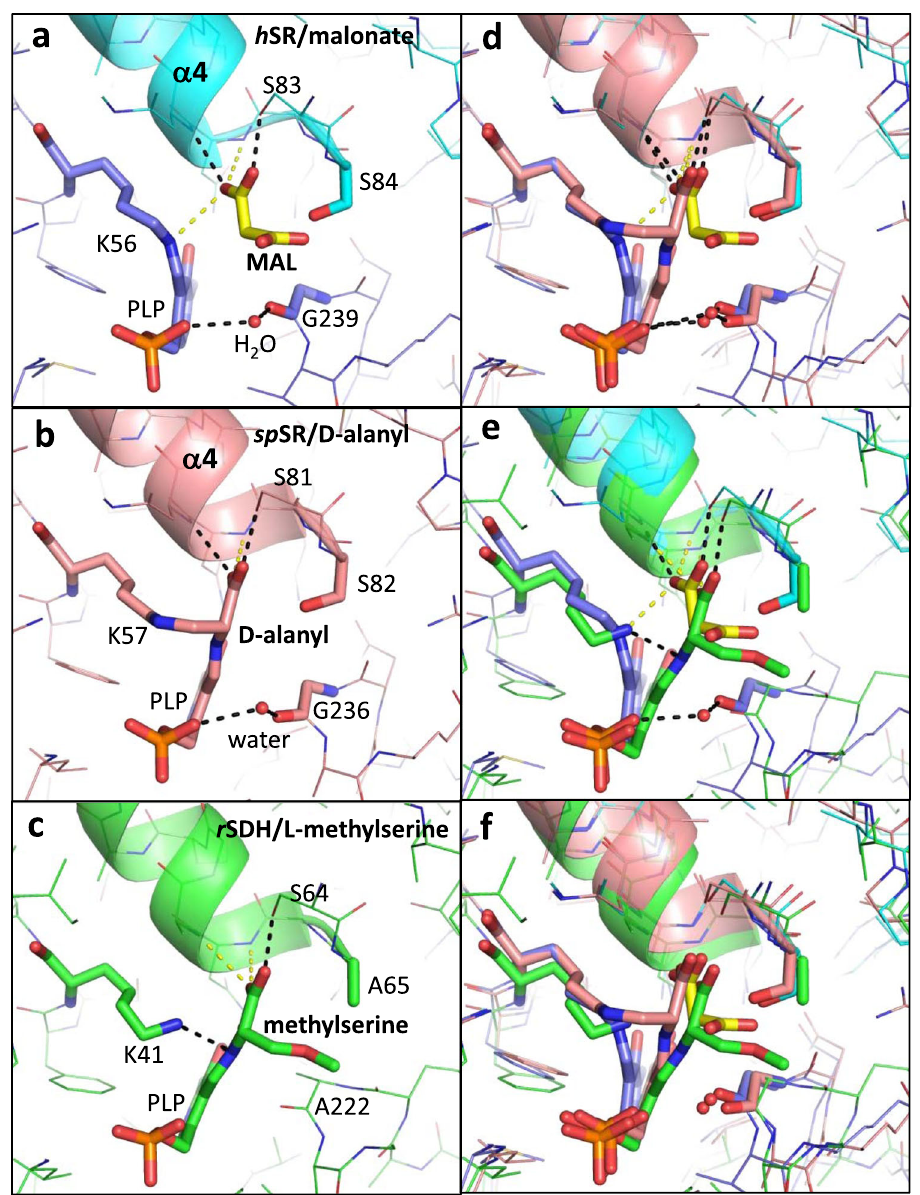
Fig. 8 Structural comparison of human SR with malonate (6ZSP), d-alanyl yeast SR (2ZPU) and rat SDH with methylserine (1PWH). a 1.60 Å structure of hSR with malonate (6ZSP). H-bonds are indicated by dotted black lines (2.5 – 3.0 Å) or dotted yellow lines (3.01 – 3.29 Å). A water molecule (small red sphere) makes H-bonds to the main-chain carbonyl of Gly 239 and the phosphate from PLP. b 1.70 Å structure of S. pombe SR with lysino-D-alanyl covalently attached to the PLP (2ZPU). c 2.60 Å structure of rat L-serine dehydratase complexed with O-methyl-serine covalently attached to PLP (1PWH). d Comparison of ( a ) and ( b ). Note the conserved water making an H-bond to the phosphate and the glycine residue. e Comparison of ( a ) and ( c ). Note Ala 65 is equivalent to Ser 84. f Comparison of ( a ), ( b ) and ( c